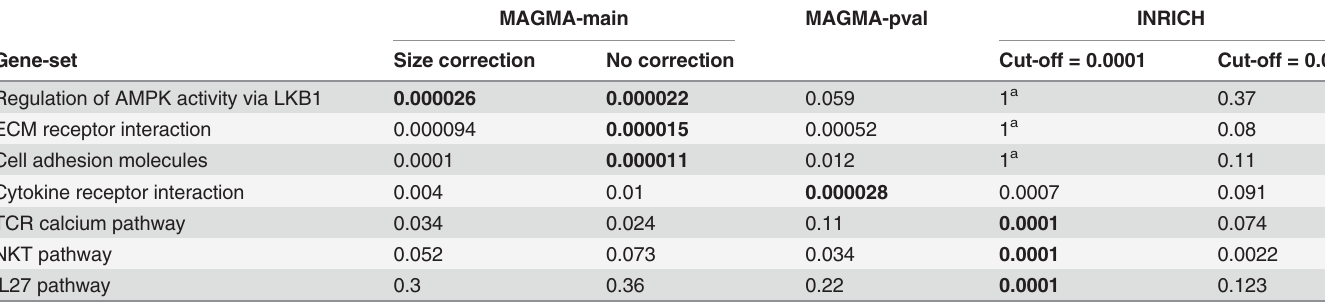
Table 4. Competitive gene-set p-values for MAGMA and INRICH significant